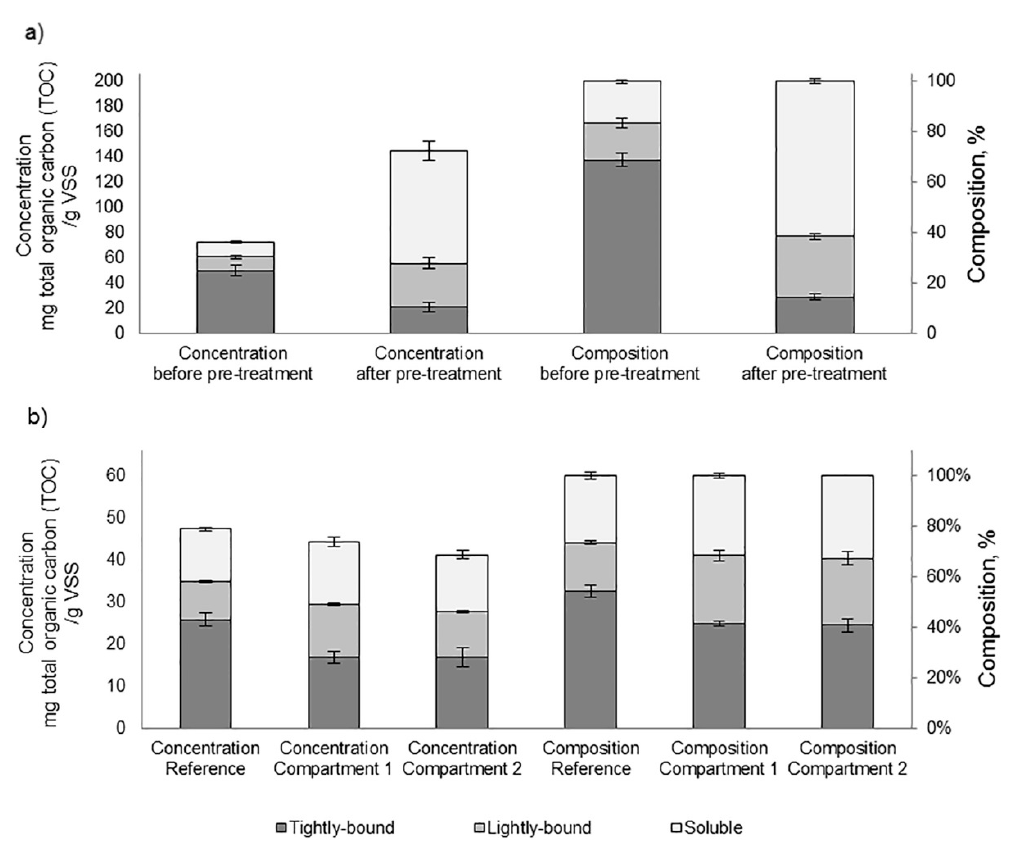
Figure 5. Extracellular polymeric substance (EPS) concentration and fractionation of EPS ( a ) before and after pre-treatment, n = 6; and ( b ) in the anaerobic liquors, n = 2. VSS, volatile suspended solid.